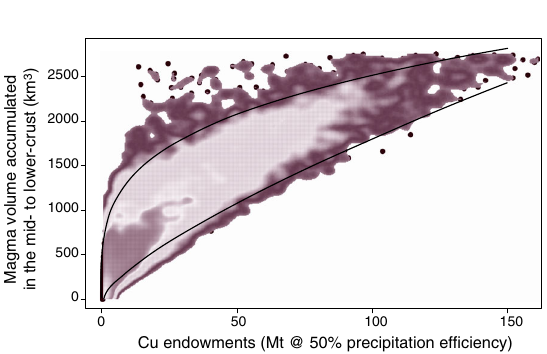
Fig. 4 Plot of magma volumes versus potential Cu endowments. Plot of magma volumes versus potential Cu endowments at 50% precipitation ef fi ciency for magmatic systems accumulated at depths corresponding to pressures of 0.4 – 1.2 GPa. Over 10000 simulations are reported from the algorithm of 13,17 . Density distribution is shown on top of the data as different color shades. More than 95% of the simulations fall within the two exponential curves, as discussed in the Methods and Table